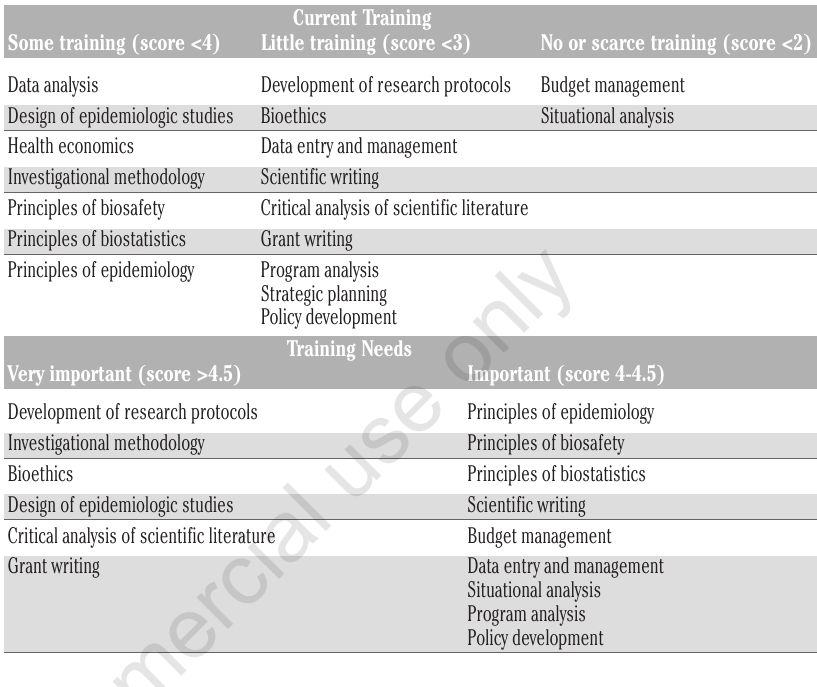
Table 3. Perceived quality of current and future training